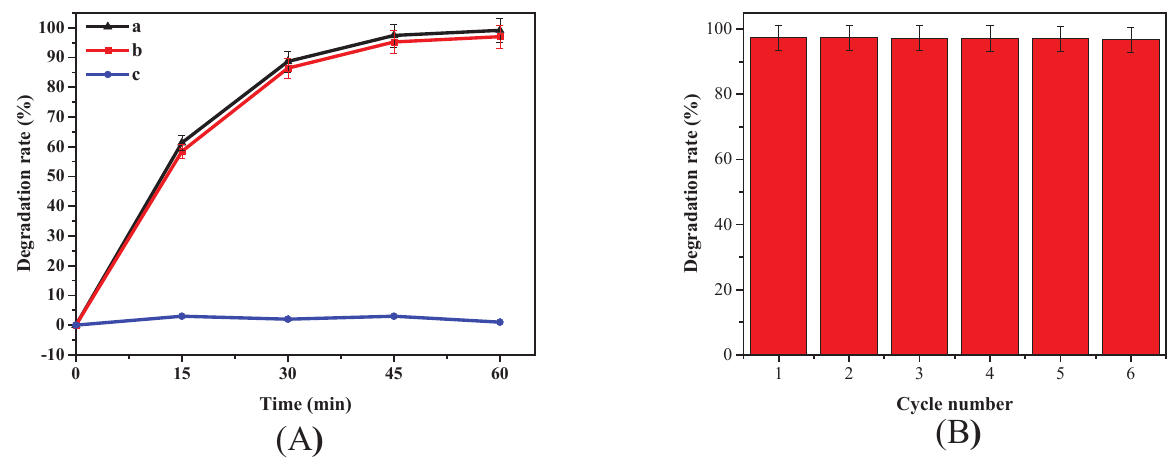
powder (a: the 2 powder (a: the reaction in the sunlight, b: 2 ). (B): ). (B): Effect of sonocatalyst reusability on the sonocatalytic 2 2